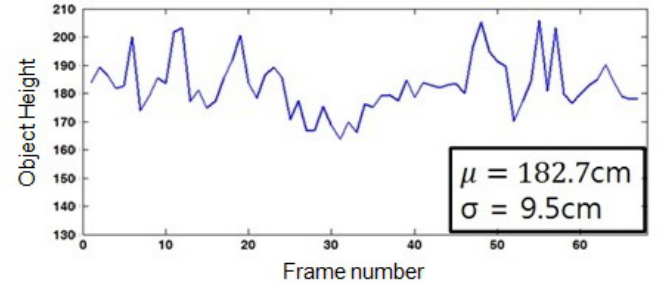
Figure 13. Variation of the object height in each frame.